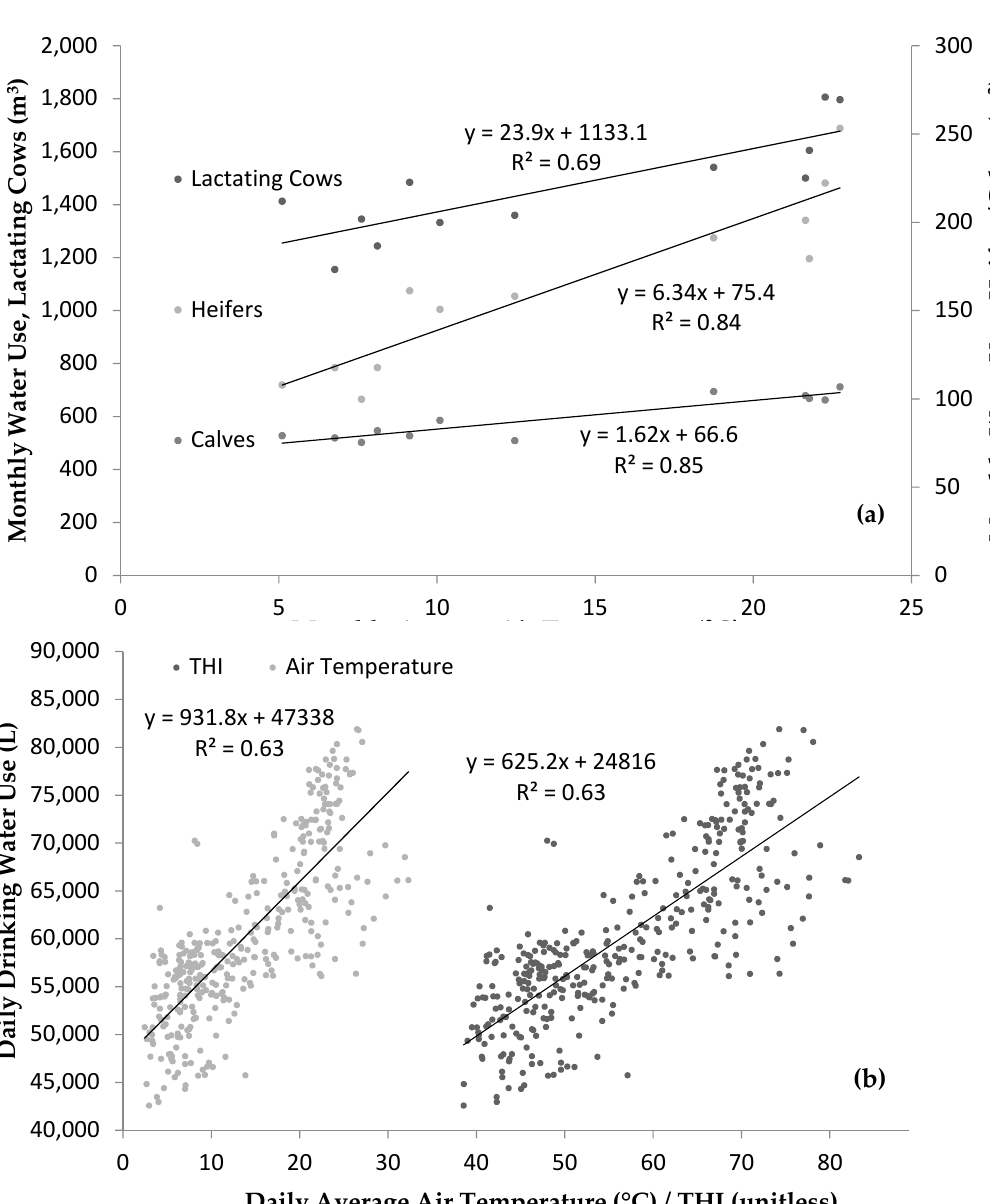
Figure 5. ( a ) Average monthly air temperature (°C) plotted against average monthly water consumption (m 3 ) for lactating cows, heifers and calves. ( b ) Total daily drinking water use (L) plotted against THI (unitless) and average daily air temperature (°C).